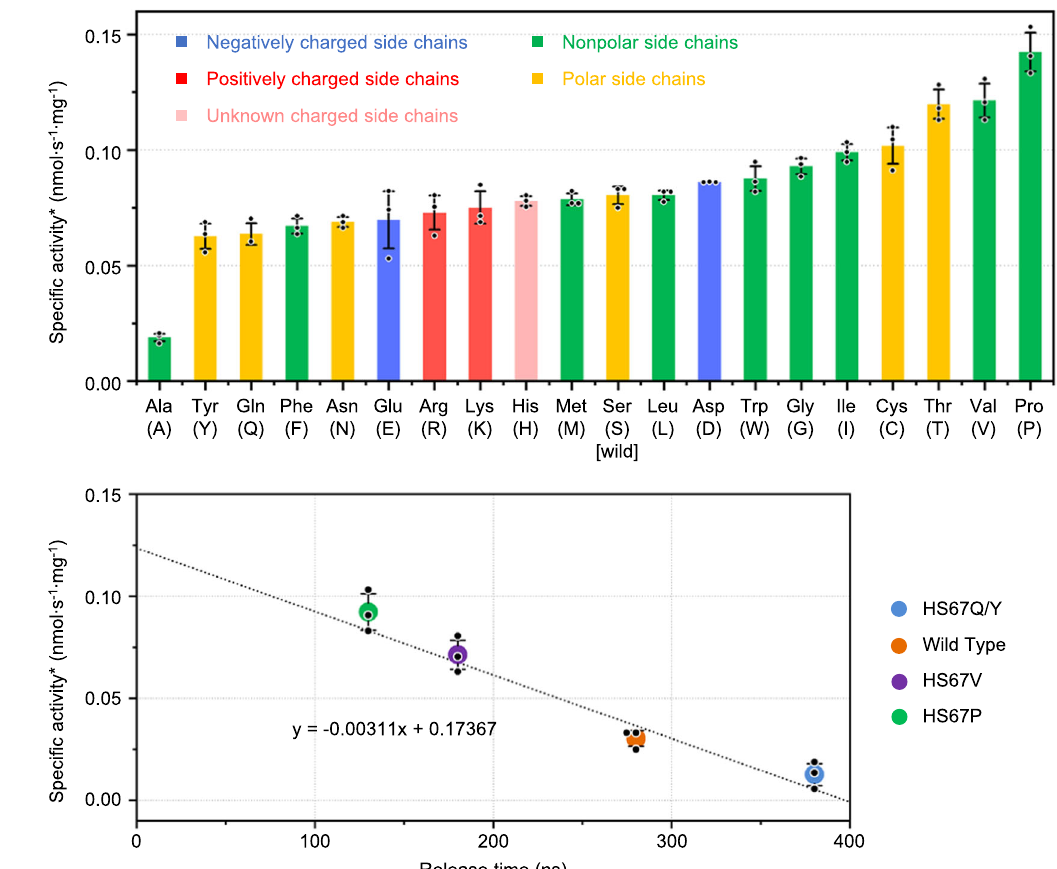
Fig. 6 Effects of mutations of H protein on glycine cleavage system (GCS) activity and its correlation with simulation results. a The activity of glycine cleavage catalyzed by the wild type (HSer-67) and its mutants of protein H. b Correlation between enzyme activity and the calculated time for the release of the aminomethyl lipoate arm from the cavity in the wild type and mutants of protein